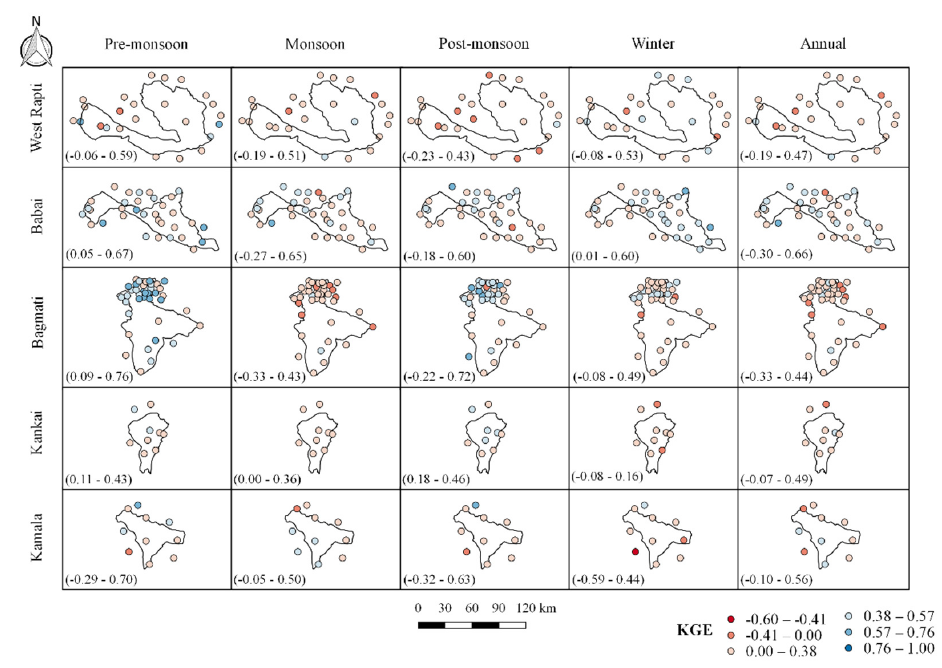
Figure 6. Spatial distributions of BIAS between the CHIRPS product and rain gauge observation at the seasonal and annual scales.